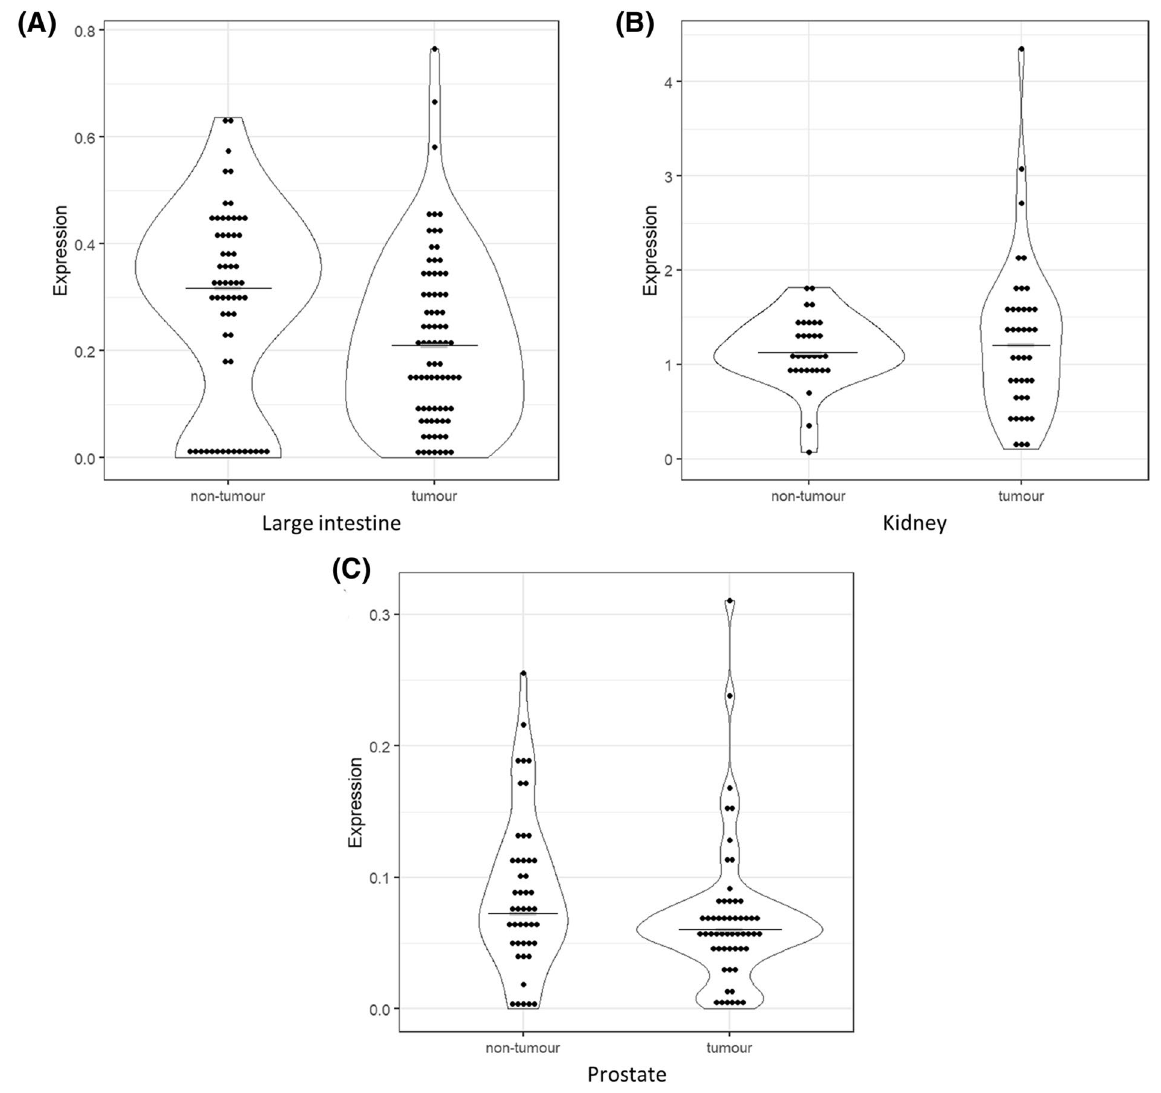
Figure 2. HNF1B mRNA overall expression levels in the tumour and non-tumour samples. ( A ) large intestine (NT = 61 samples; T = 78 samples; p = 0.019); ( B ) kidney (NT = 32; T = 40; p = 0.968); ( C ) prostate tissue (NT = 46; T = 55; p = 0.047). Data is visualized as violin plots. Each dot represents one sample. Expression is relative to POLR2A ( POLR2A expression = 1). Black line represents